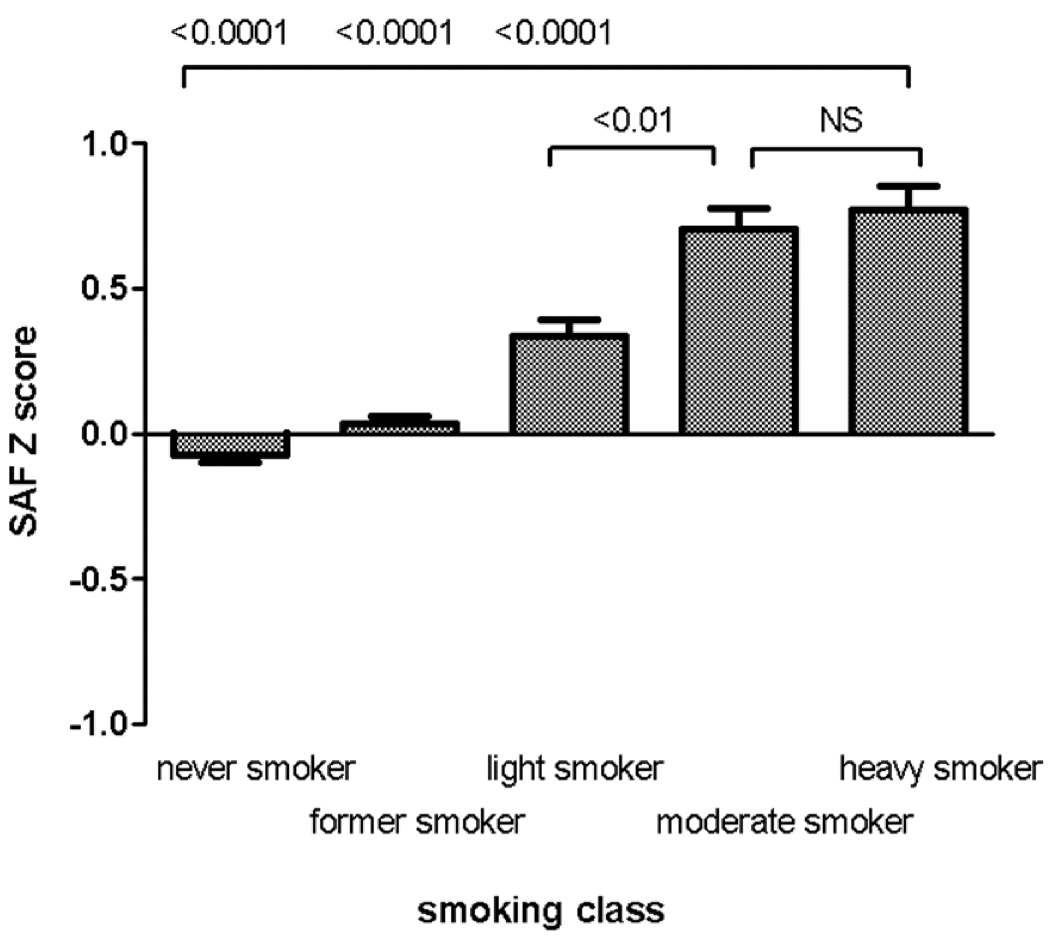
Fig 1. Skin autofluorescence stratified for smoking class (LifeLines Cohort Study). Bars represent mean SAF Z scores (adjustedfor age, creatinine clearanceand diabetes), whiskersreflect standarderror of the mean. Never smoker (n = 3670), Former smoker (n = 3321), Light smoker (0–10 gram tobacco per day, n = 878), Moderate smoker (10–20 gram tobacco per day, n = 537), heavy smoker ( > 20gram tobacco per day, n = 475). SAF, skin autofluorescence; AU, arbitrary units; NS, not